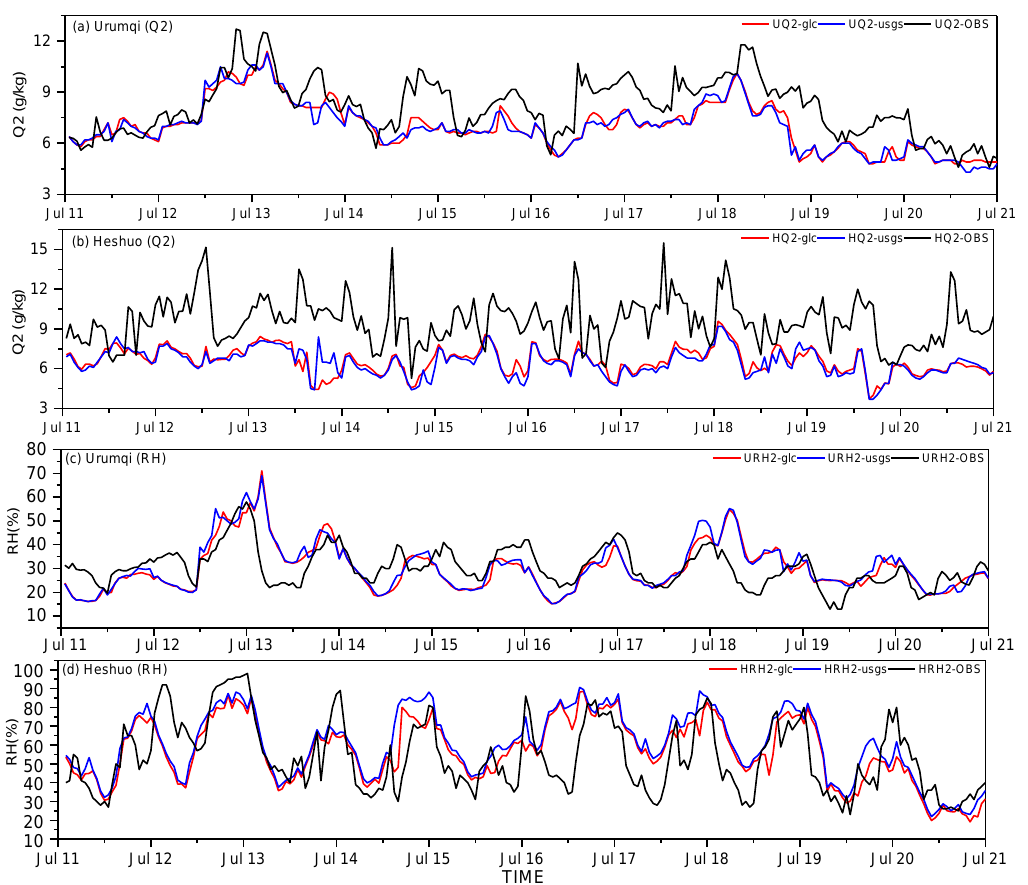
Figure 10. Q2 and RH at Urumqi ( a,c ) and Heshuo ( b,d ). GLC2015 (red line), USGS (blue line) and observations (black line) are shown.